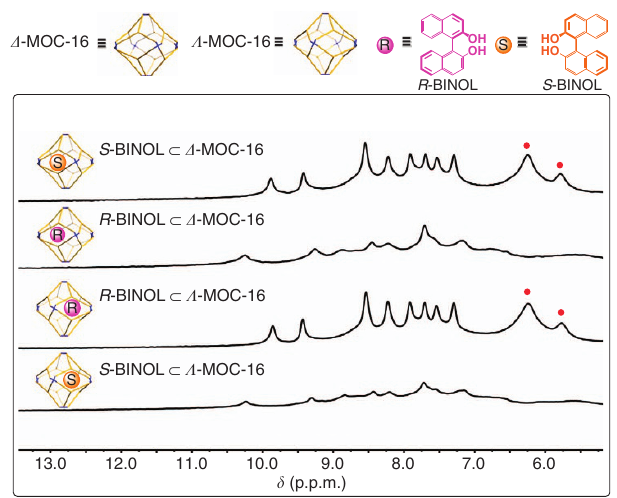
Figure 4 | 1 H NMR enantiodifferentiation experiments. Sequestration of enantiomeric R - or S -BINOL guests by homochiral D - or L -MOCs-16 ( d 6 -DMSO/D 2 O ¼ 1/5, 298K). Red circles denote signals of encapsulated